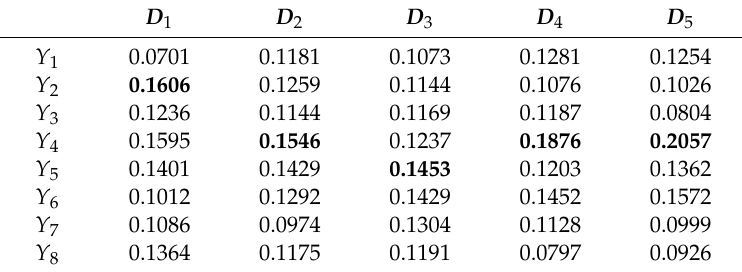
Table 10. The attribute’s weight of 5 experts calculated by entropy method.